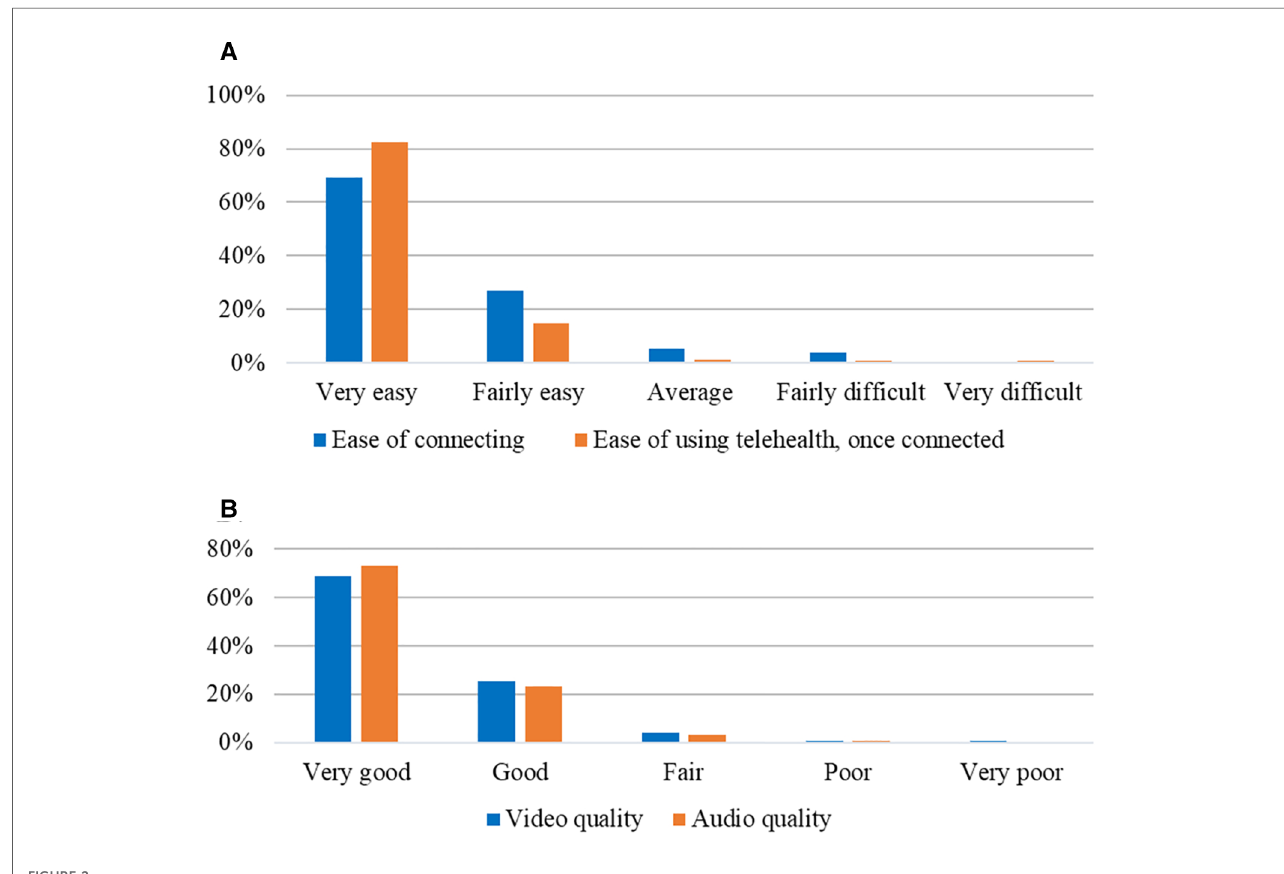
FIGURE 2 Ease and quality of telehealth experience.